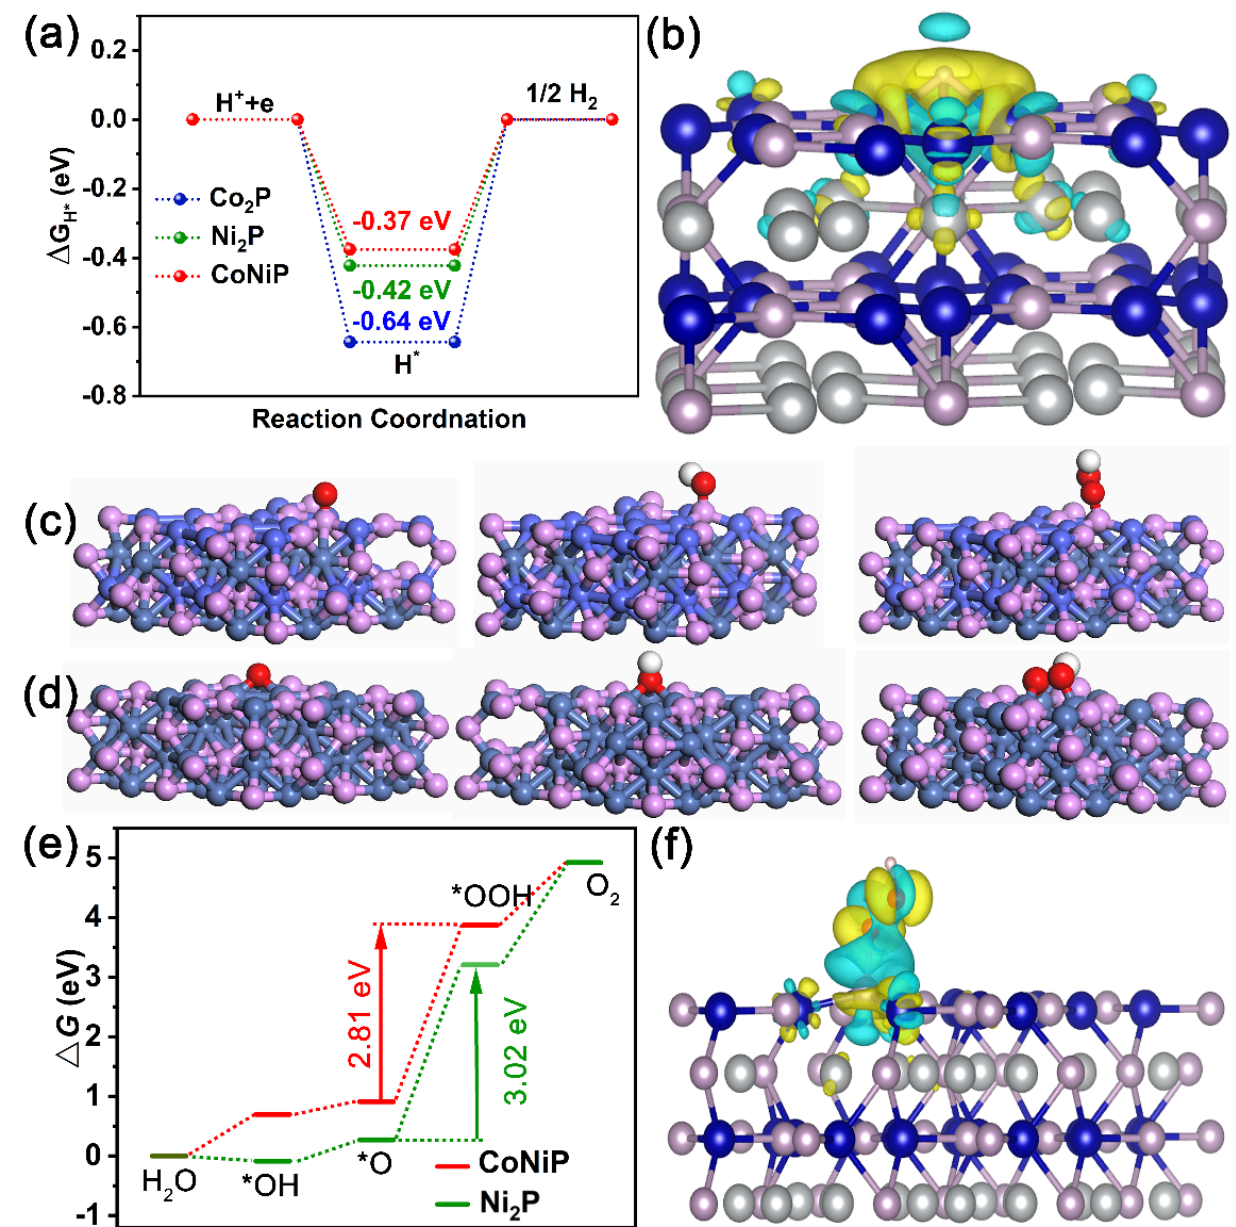
Figure 8. ( a ) The ∆ G H* values for CoNiP, Co 2 P and Ni 2 P. ( b ) Charge density difference plots at the surface of CoNiP for HER. Structures of *OH, *O and *OOH intermediates of the OER process on ( c ) CoNiP and ( d ) Ni 2 P. ( e ) Gibbs free energy diagrams for OER processes. ( f ) The charge-density difference of plots at the surface of CoNiP for OER.